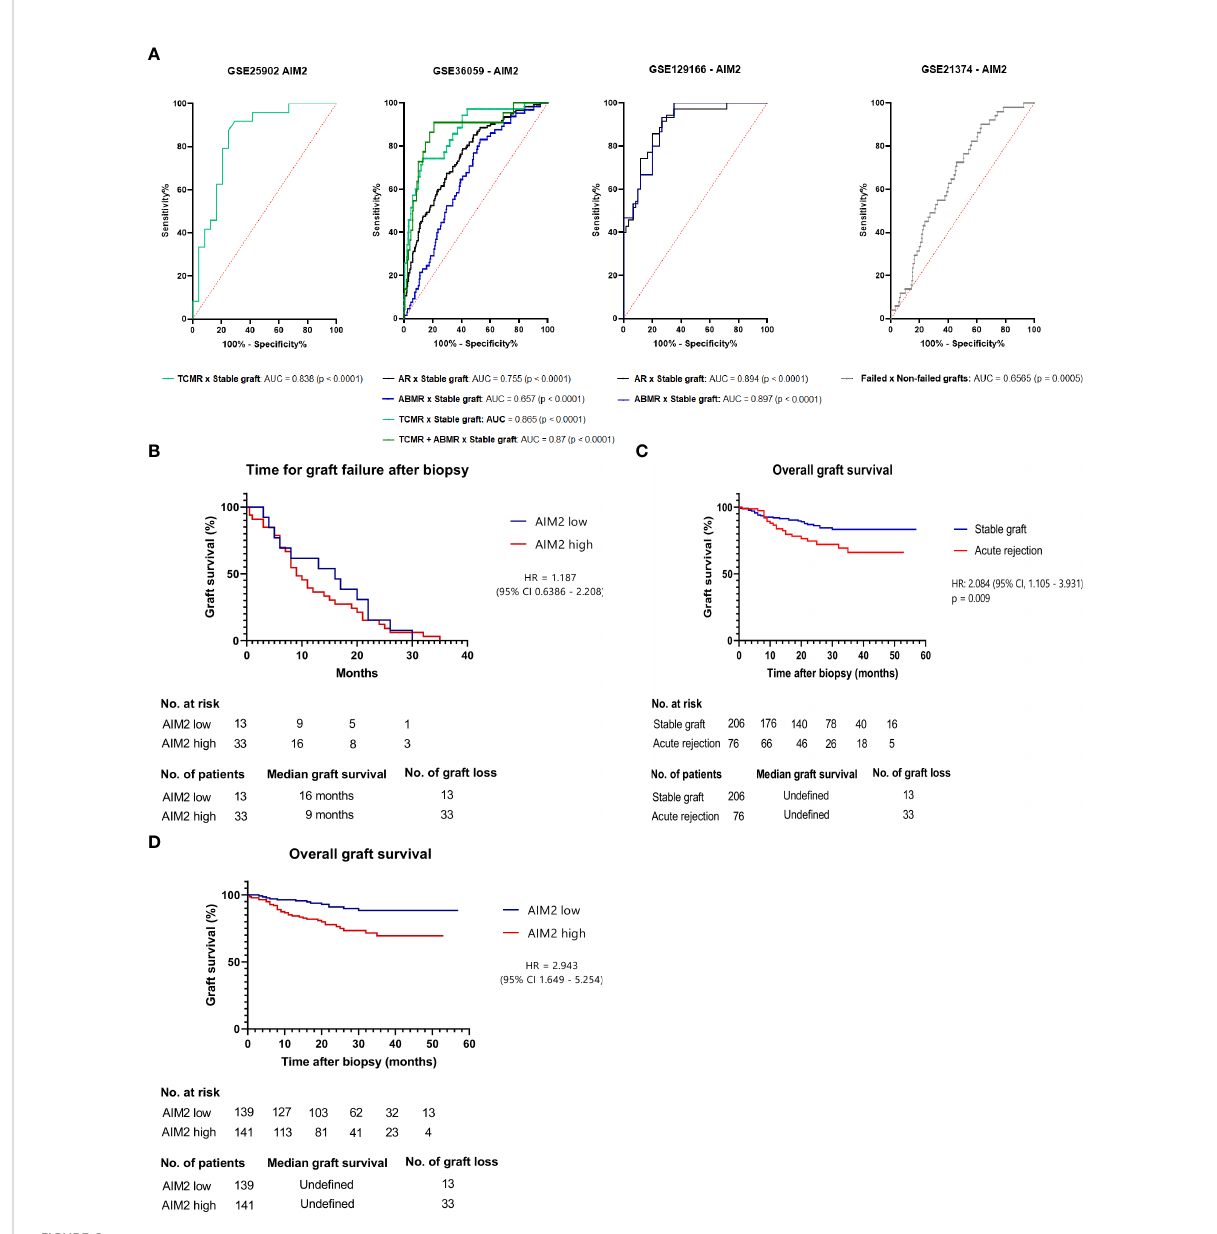
FIGURE 6 Clinical outcomes linked to AIM2 (A) Receiver Operating Characteristic Curve (ROC) depicting AIM2 accuracy for GSE25902, GSE36059, GSE129166, GSE21374 and its respective TCMR or ABMR samples (B) Graft survival for GSE21374 stable graft and acute rejection samples predicted by Kaplan-Meier curve on log-rank (Mantel-Cox) test. Groups were separated in low or high AIM2 levels according to a 5.738 cut-off that showed 78.95% sensitivity and 71.84% speci fi city for acute rejection prediction on ROC curve (C) Graft survival for acute rejected samples of GSE21374, applying same 5.738 threshold to determine AIM2 high or low groups. Statistics were determined by the log-rank test (D) Time for graft failure after biopsy for GSE21374